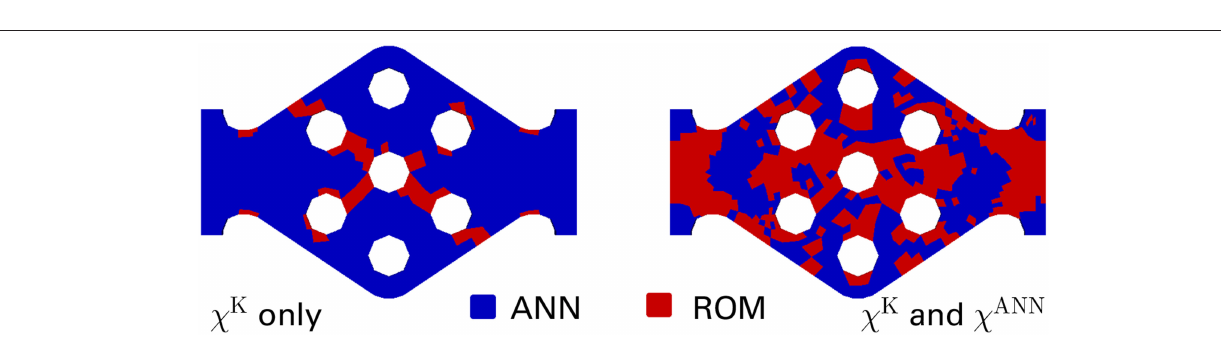
where the hybrid curve from Figure 7 and the FE 2R curve for the ROM featuring 32 modes are also shown for